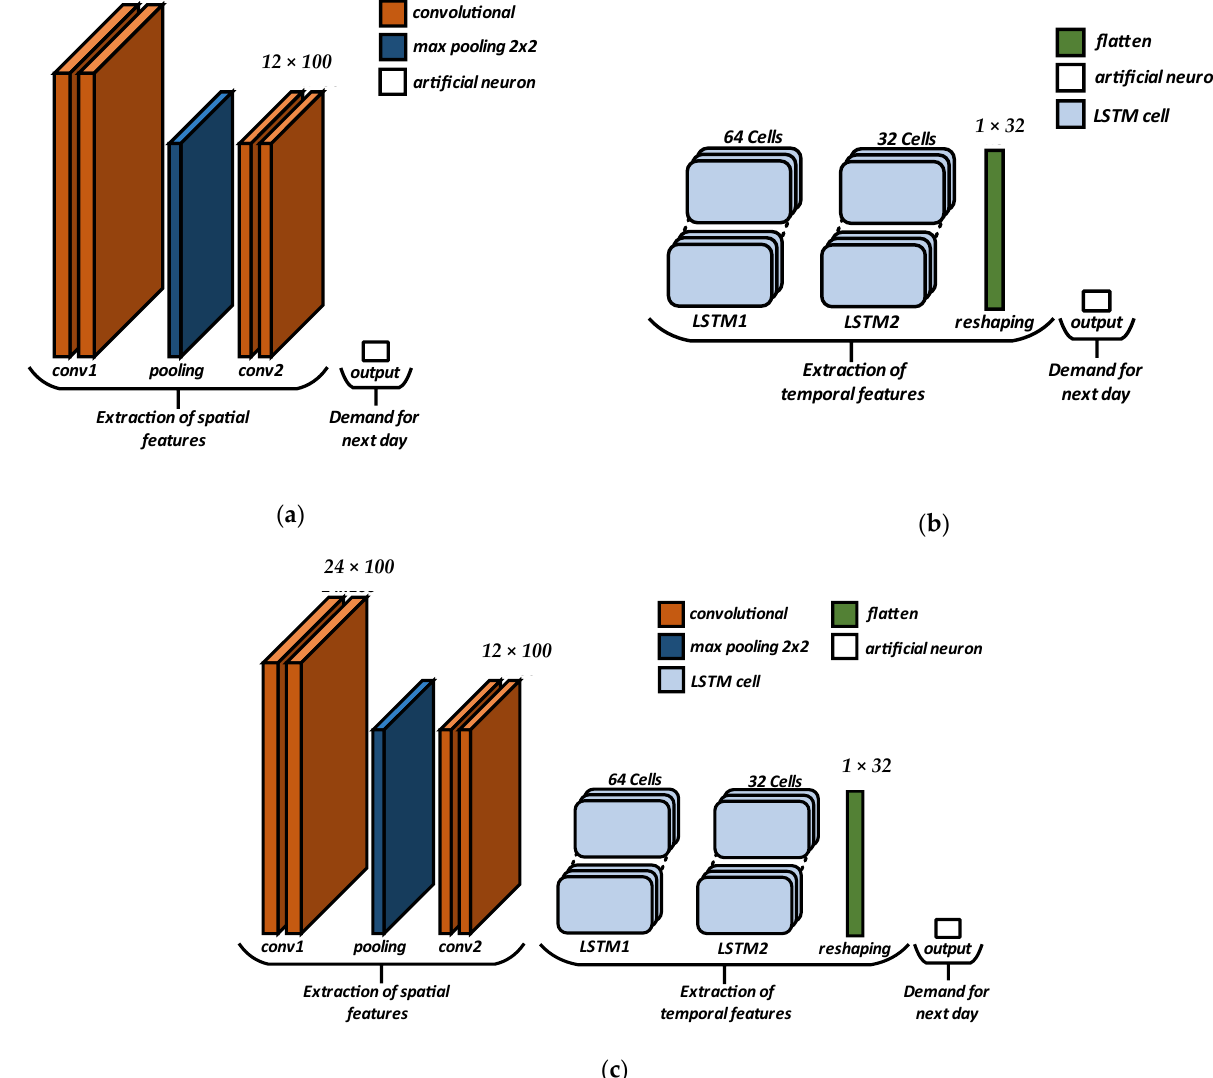
Figure 4. Architectures of the deep neural networks proposed in this study for demand forecasting: ( a ) convolutional network with four convolutional layers using the ReLU activation function, interleaved by a pooling layer, followed by an output neuron with a linear activation function; ( b ) recurrent network with two LSTM layers for extracting temporal features, followed by a reshaping layer and an output neuron with a linear activation function; ( c ) mixed convolutional-recurrent network with four convolutional layers and two LSTM layers for extracting spatial-temporal features.